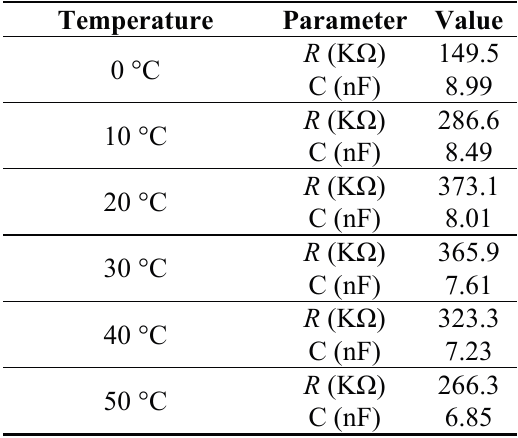
Table 2. Results of fitting in the temperature range of 0 °C to